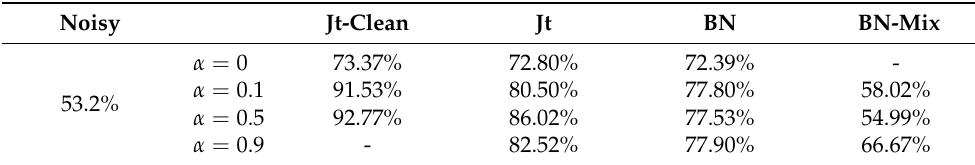
Table 2. Classification accuracy for different architectures with different α